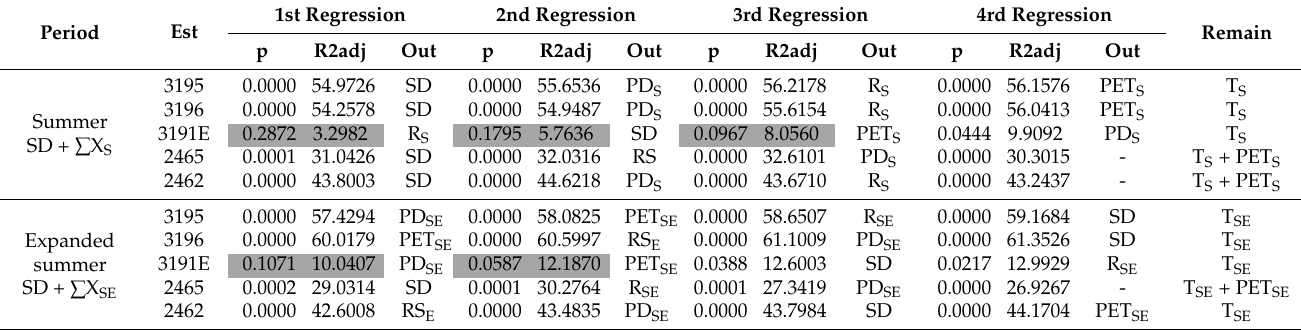
Table 4. Multiple regressions and ANOVAs for summer and extended summer periods.